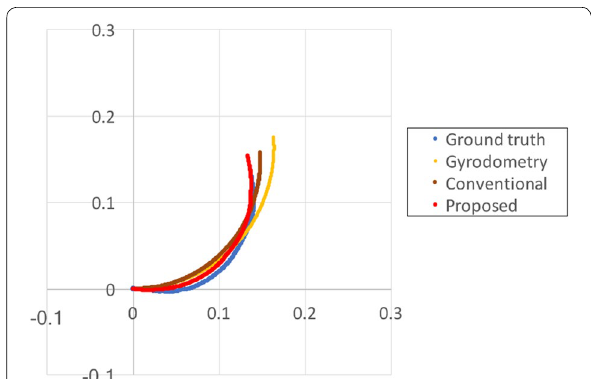
Fig. 15 Result of position estimation: slope angle is 8 ◦ , input velocity is 5 cm/s, and input angular velocity is 20 ◦ /s